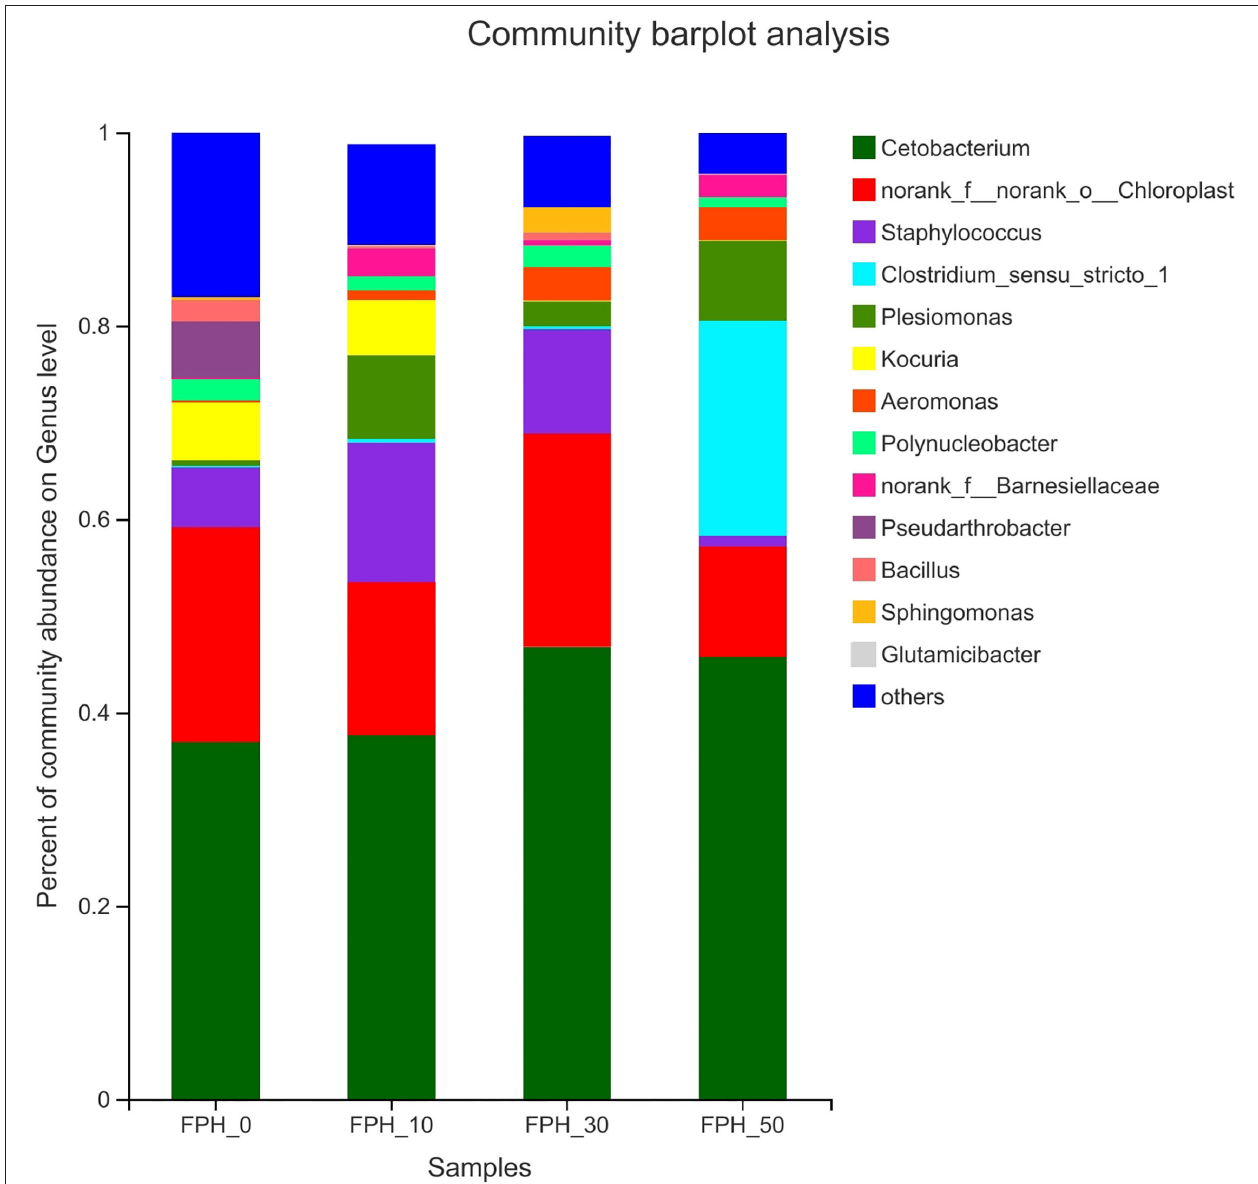
FIGURE 7 | Histogram of relative abundance of intestinal microflora of largemouth bass ( Micropterus salmoides ) fed the diets containing different supplementation levels of fish protein hydrolysate (FPH) at the genus level.